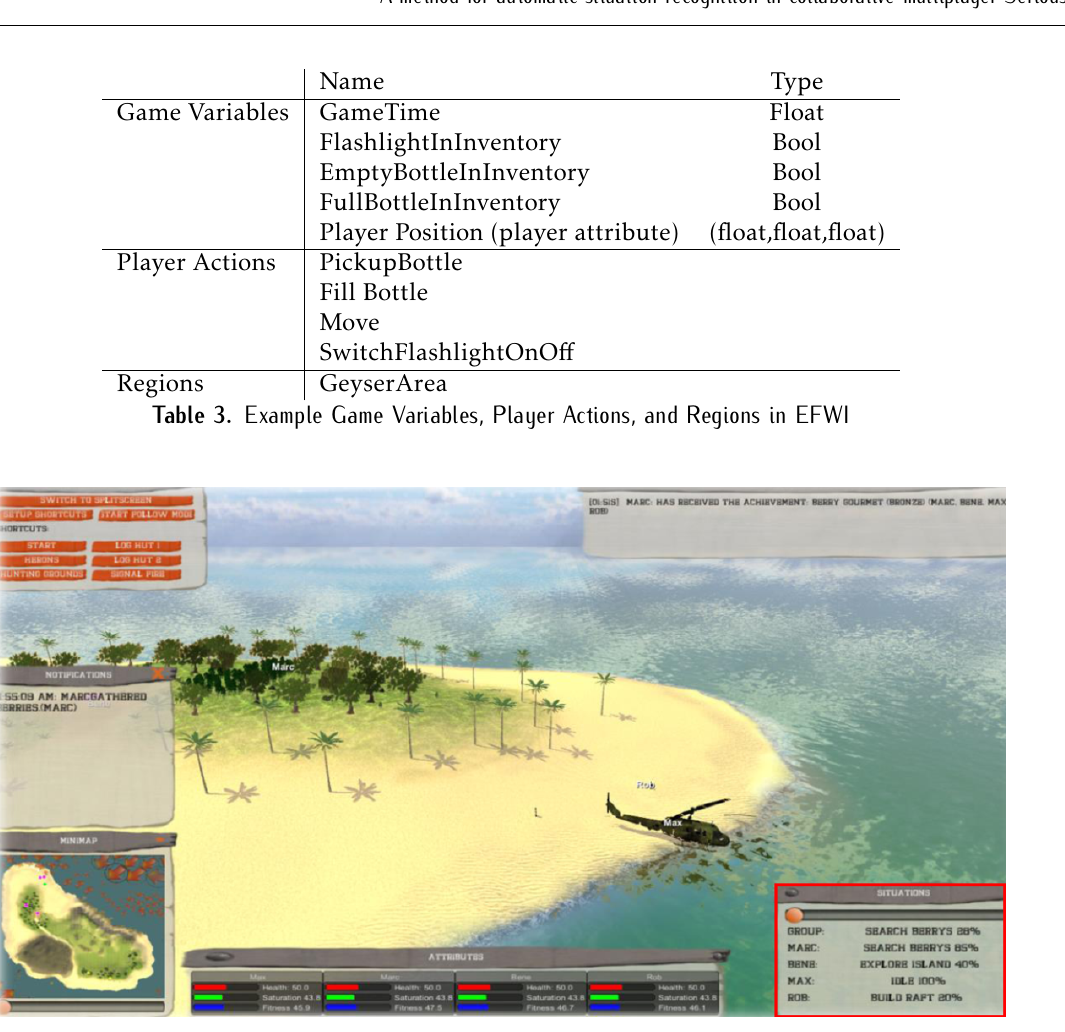
Figure 2. Game Master overview over the game including the situation